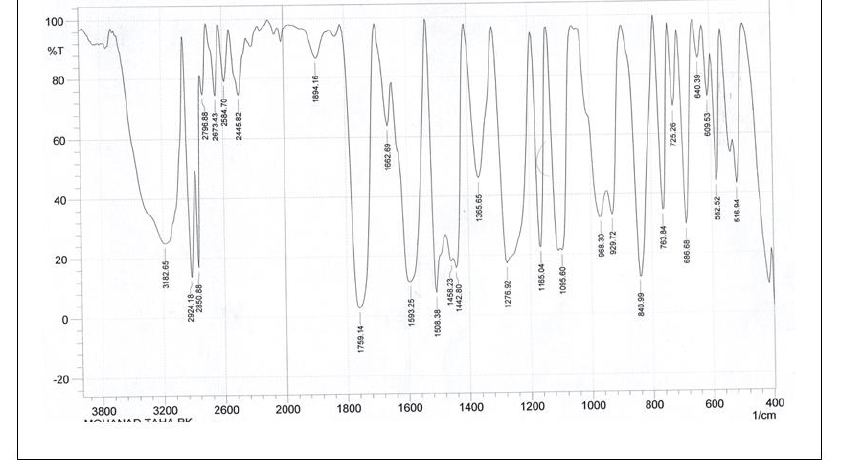
Fig. 3. FT-IR spectrum of PC polyester